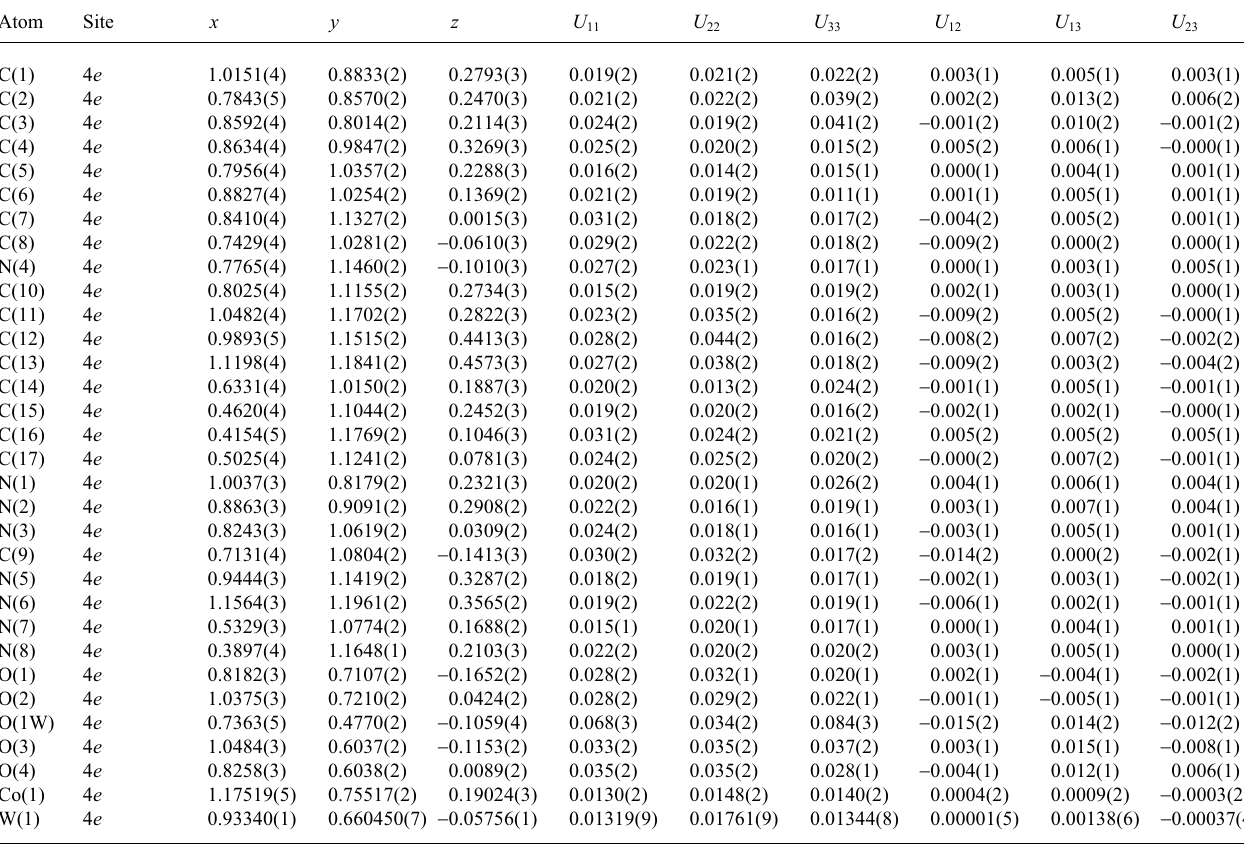
Table 3. Atomic coordinates and displacement parameters (in Å 2 )